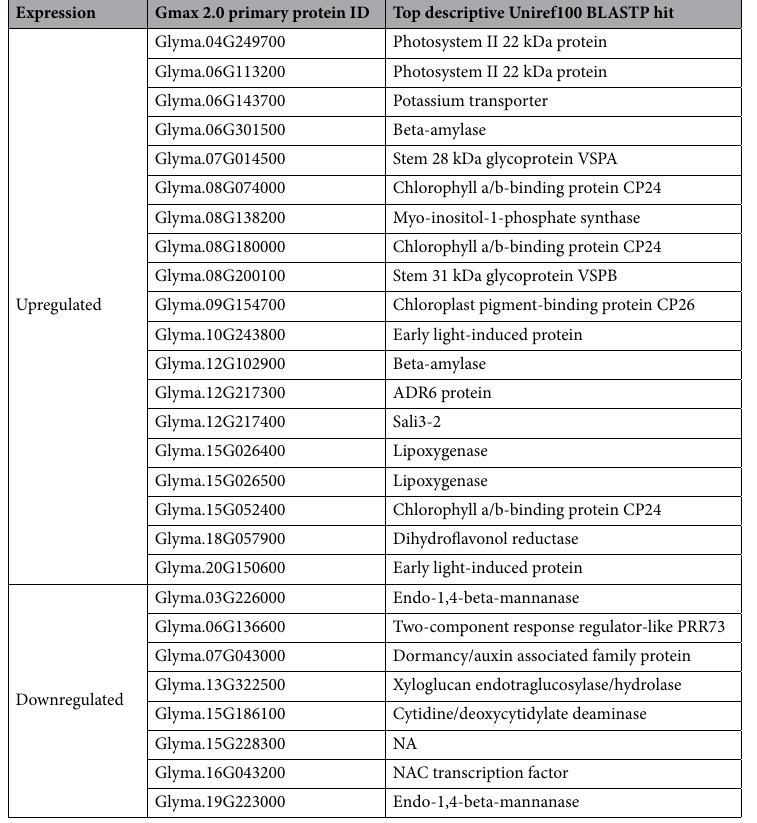
Table 6. Differentially expressed genes in both R5 + 14 d and R5 + 28 d datasets after the thinning treatment at the R5 growth stage. Upregulated or downregulated indicate that expression levels were significantly upregulated or downregulated in the thinning-treatment plot compared to the dense-treatment plot. Analysis was performed using the software SeqMonk v1.38.2 and Java